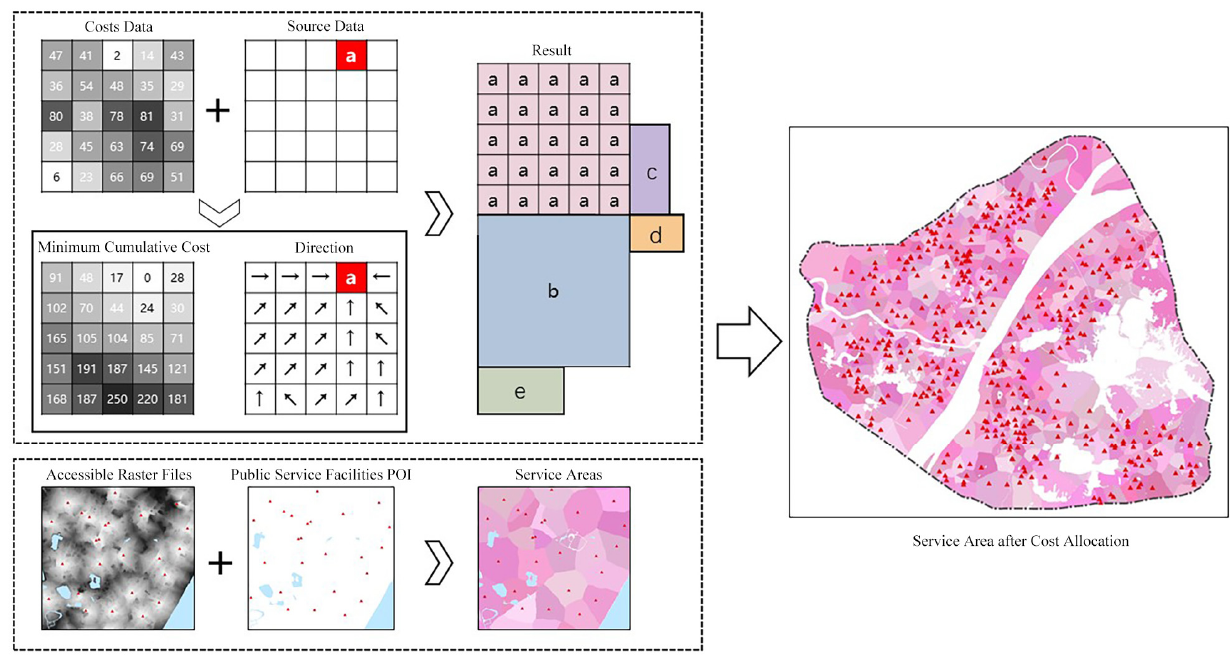
Figure 3. Principles of cost service area construction.